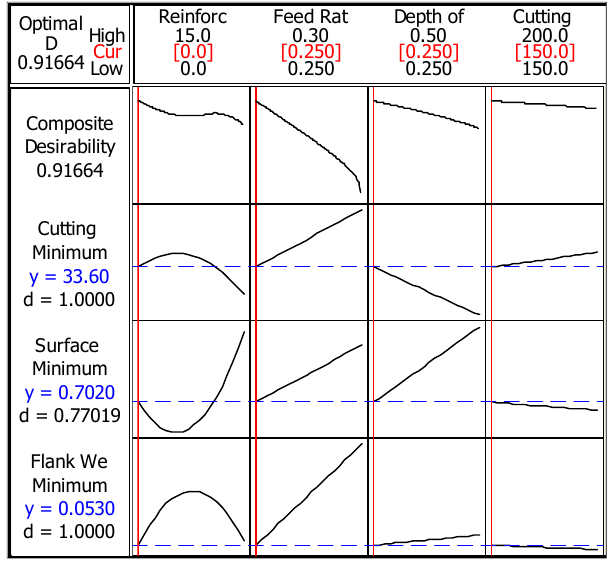
Figure 11. Multiple optimization results for characteristics .